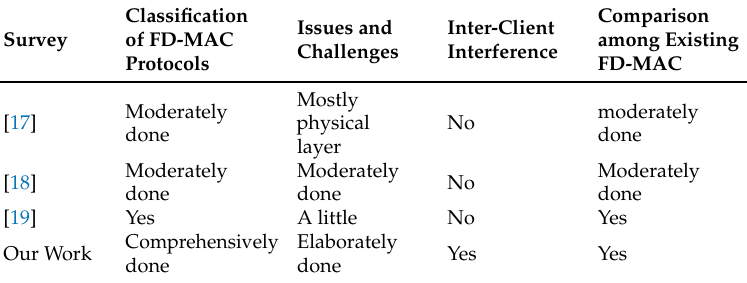
Table 1. Comparison among existing surveys and this